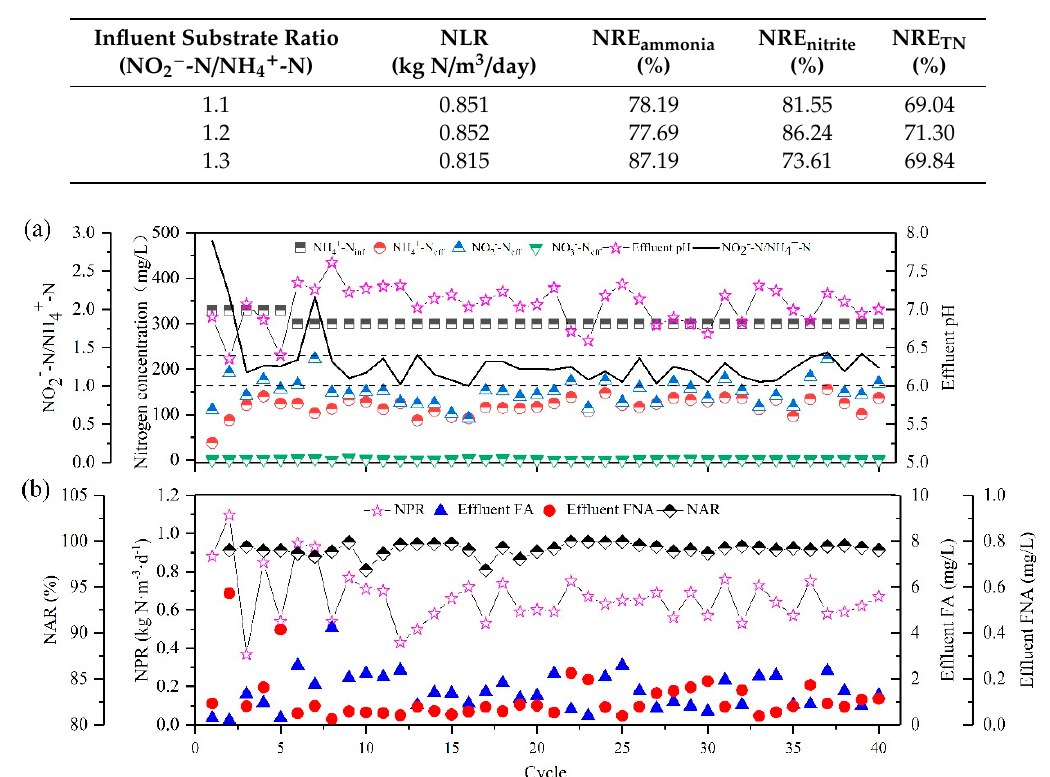
Table 3. E ff ects of di ff erent influent substrate ratios on the anammox reactor.